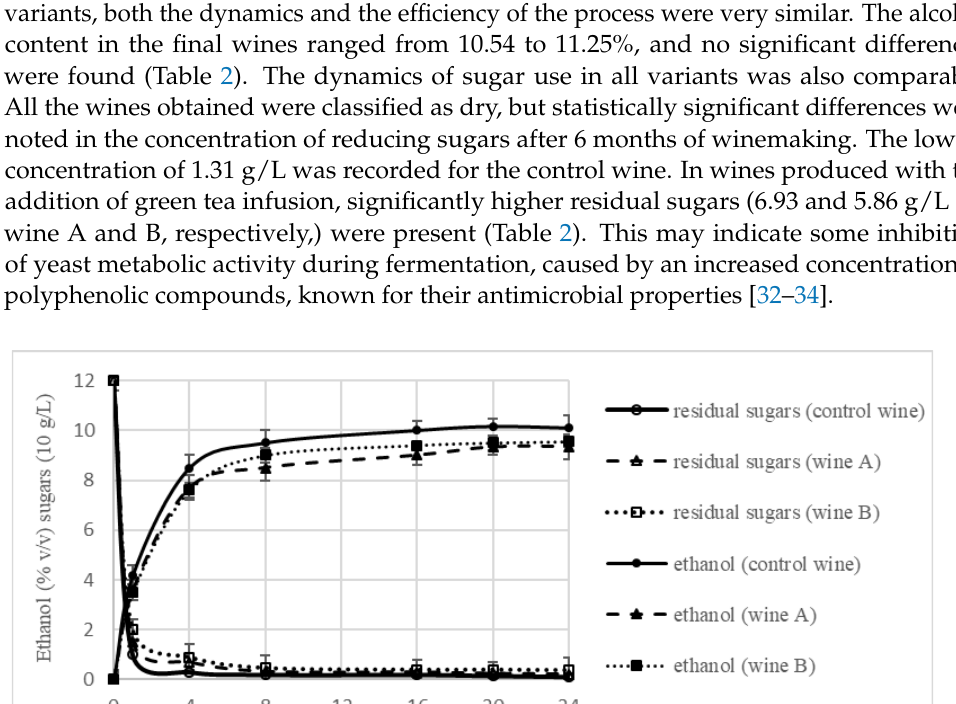
Table 2. Chemical characteristic of musts and cherry wines.